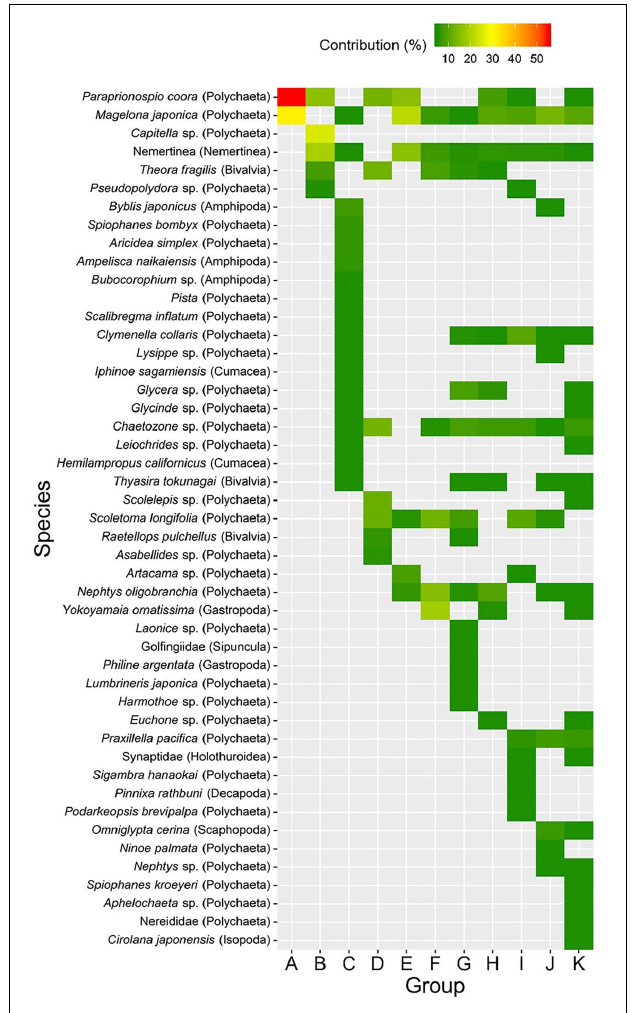
FIGURE 5 | Results of SIMPER analysis showing percentage contributions of macrofaunal species that accounted for most of the similarity ( > 70%) within each of the 11 cluster groups